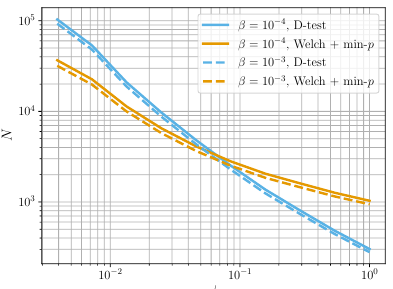
Figure 6: Number of traces N required to detect for a fixed false negative rate β on simulated traces with SNR = 0 . 01, and varying density φ